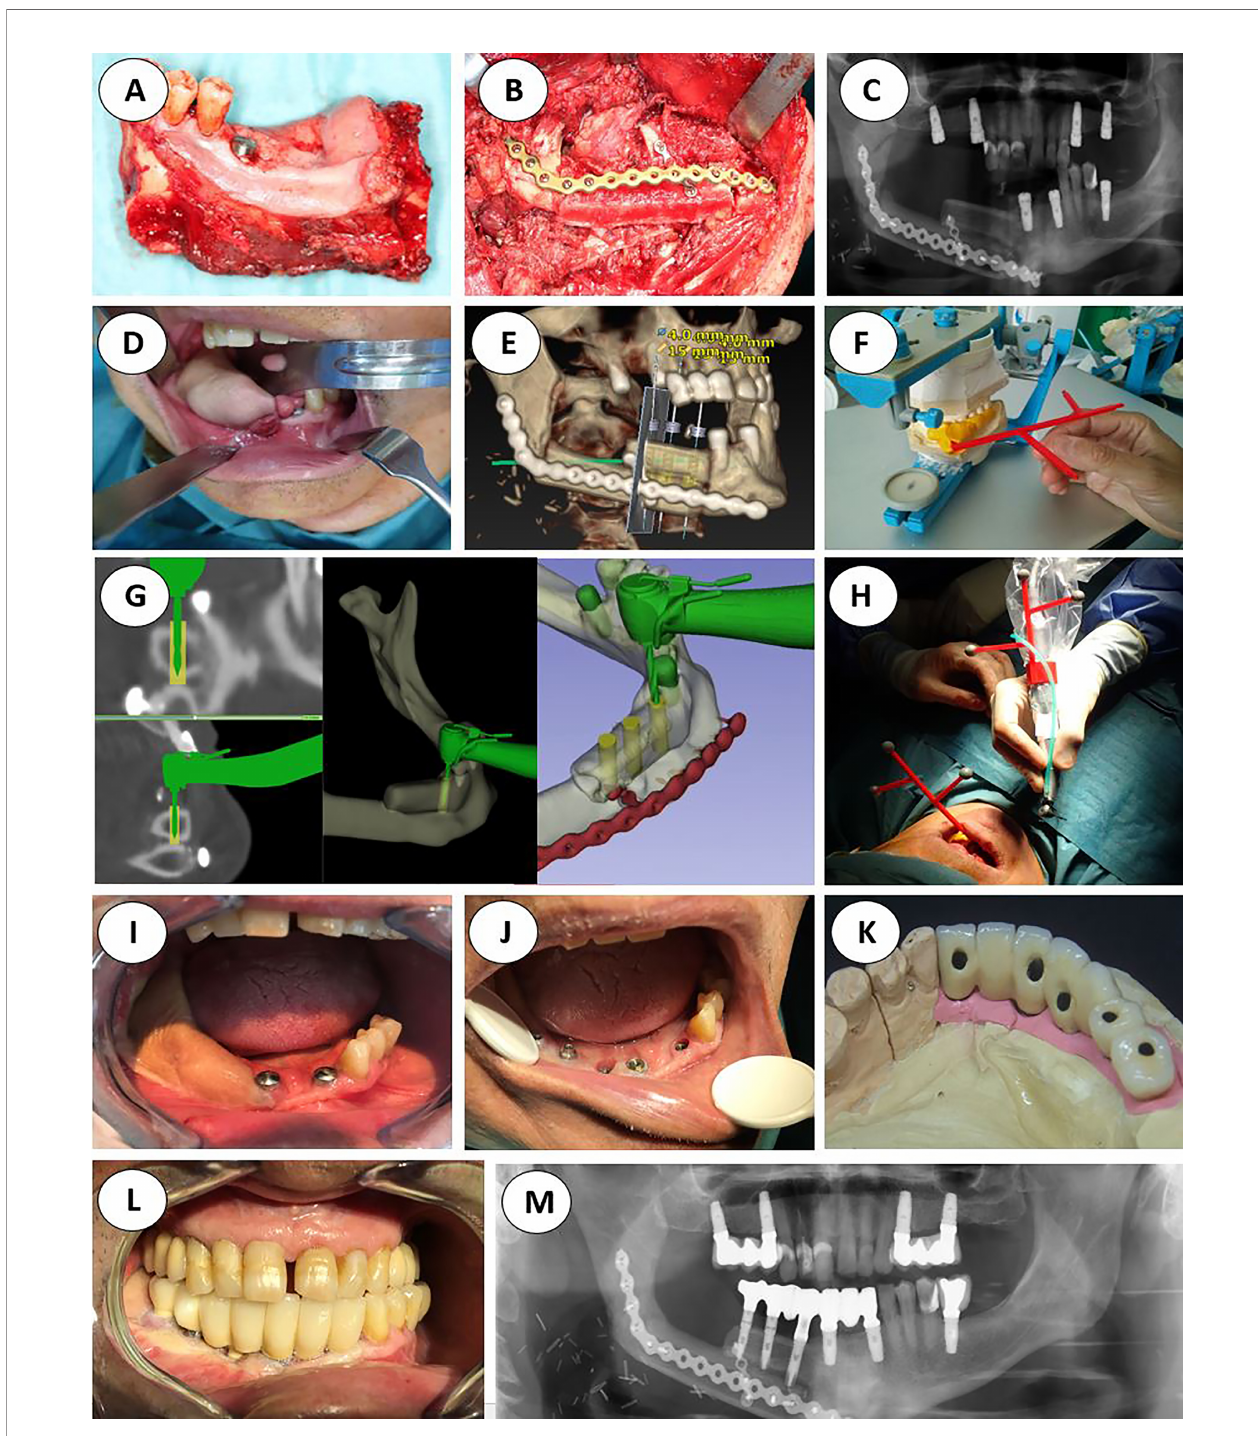
FIGURE 2 | Initial protocol example, from the ablative surgery to the fi nal orthopantomogram (A) Right segmental mandibulectomy. (B) Double-barrel fi bula fl ap in place. (C) Postoperative orthopantomography. (D) Redundant fi bula skin paddle. (E) Implant placement virtual surgical planning with Nobel Clinician-DivX software. (F) Teeth supported silicone jig holding the 3D-printed dynamic reference frame. (G) Intraoperative screen view of the navigated handpiece and the real-time drilling trajectory. (H) Handpiece and patient ’ s optical markers ready for dynamic navigation. (I) Still redundant skin paddle after implant surgery. (J) Intraoral view after vestibuloplasty and implant second phase. (K) Screw retained porcelain fused to metal fi xed prosthesis lingual view. (L) Final occlusion. (M) Final panorex with the prosthesis in place.